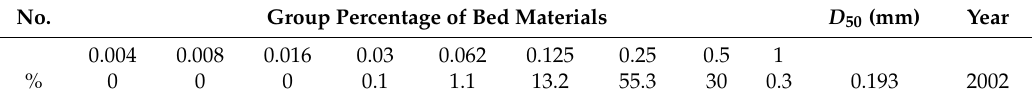
Table 2. The fraction of bed material.